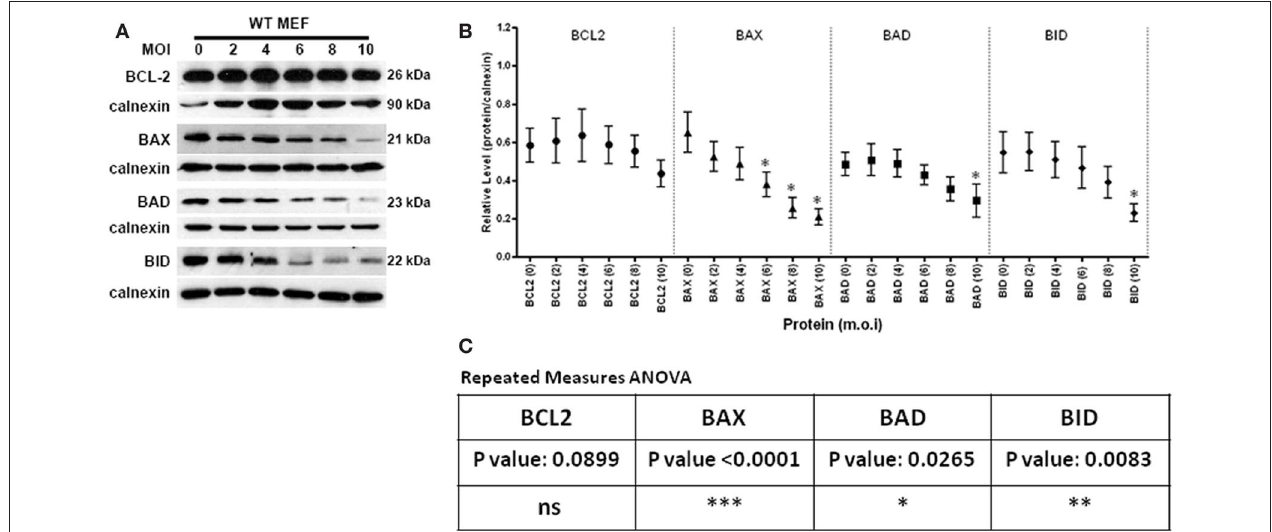
the following number of independent experiments were used to assemble the presented data: BCL 2–8 experiments, BAX-10 experiments, BAD-8 experiments and BID-6 experiments. The error bars represent the SE of the mean (symbol). A single asterisk above an error bar signifies a significant data point relative to the uninfected control with a p -value < 0.05 employing the Dunnett pairwise test. (C) Repeated measures ANOVA analysis relative to the uninfected control was performed. A p -value of 0.05 or higher were considered to be not significant (ns). Values of low significance (*0.01–0.05),